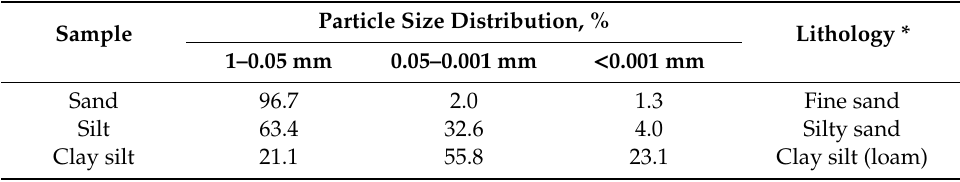
Table 2. Particle size distribution in soil